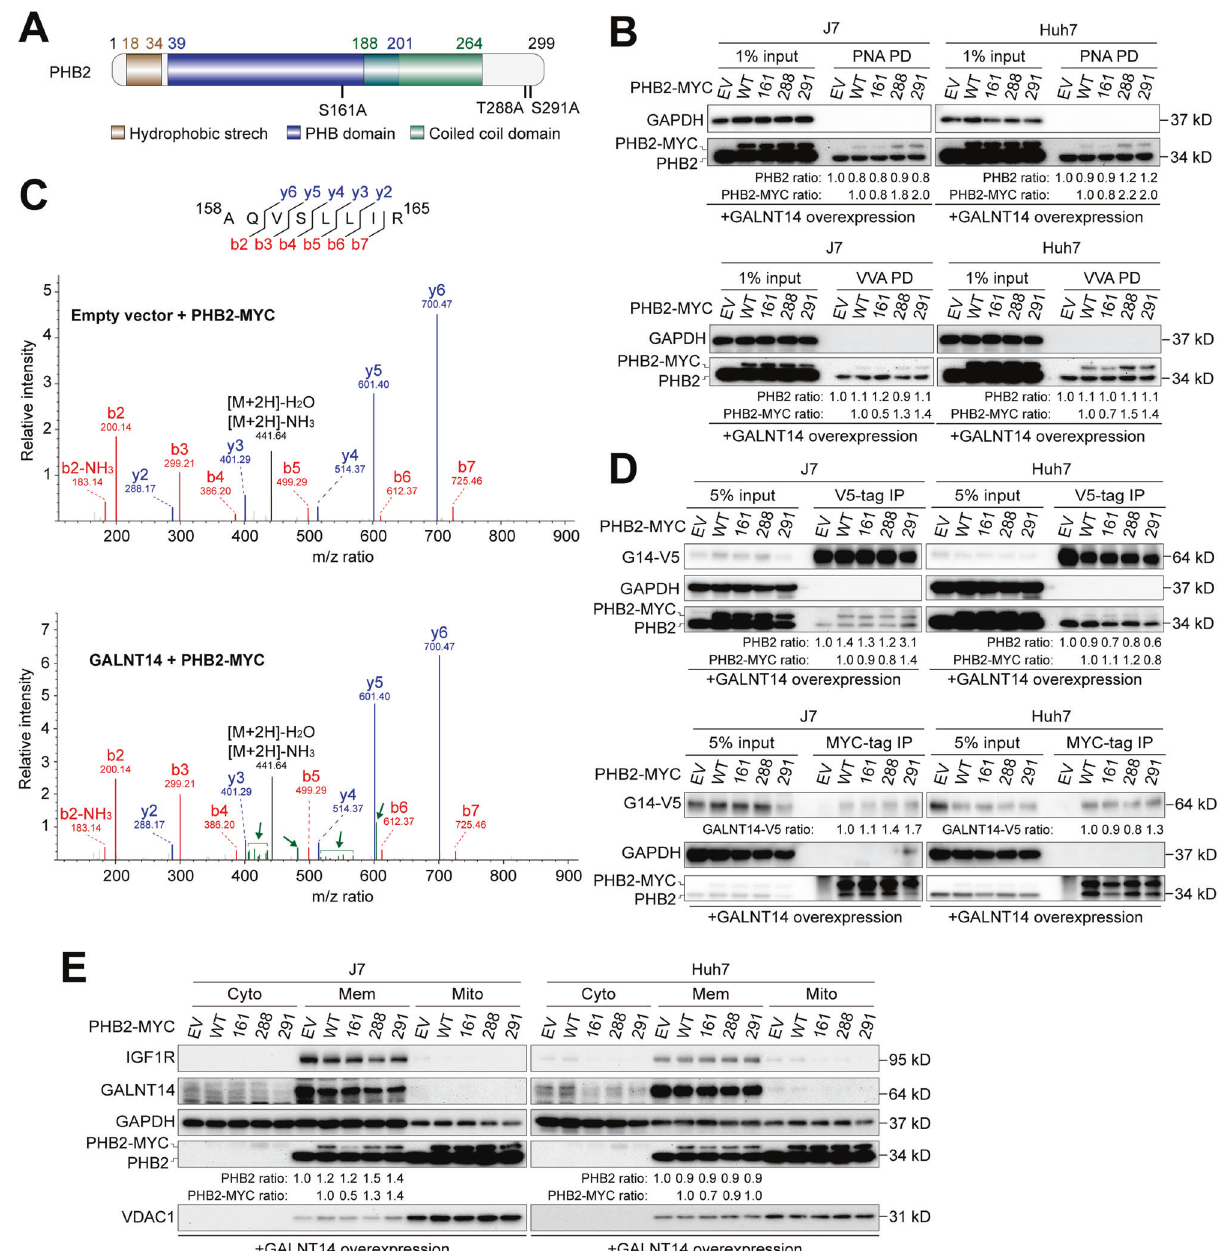
Fig. 4 Serine residue 161 of PHB2 serves as a target site for GALNT14-mediated O -glycosylation. A Schematic representation of predicted PHB2 domains and residues as O -glycosylation hotspots. B PNA- or VVA-mediated pulldown of PHB2 was performed using lysates of cells transfected with the indicated plasmids. C Spectrum of Serine-161-containing peptides derived from LC/MS/MS. Green bars and arrows indicate that there were certain uncharacterized modi fi cations on the fragmented peptides. m/z, the mass-to-charge ratio, where m is the molecular or atomic mass number and z is the charge number of the ion. D Western blot analysis following co-immunoprecipitation using samples of HCC cells transfected with the indicated plasmids. E Western blot analysis of subcellular fractions fractionated from cells transfected with the indicated plasmids, including cytosolic (Cyto), membranous (Mem) and mitochondrial (Mito). IGF1R was used as a speci fi c marker for the membrane fraction, while VDAC1 was used as a marker for the mitochondrial conducted. As shown in Fig. 7A, when IGFBP6-His immunopreci- pitation was performed, a comparable amount of endo-PHB2 was detected in all the pellets. However, a signi fi cantly reduced abundance of exo-PHB2 was detected in the samples expressing PHB2 has been demonstrated to co-localize and physically interact the Ser161Ala mutant. Consistently, when PHB2-MYC was with the IGF1R modulator IGFBP6 on the cell membrane [19]. To immunoprecipitated, IGFBP6 was detectable in the co- immunoprecipitants of the wild-type or Thr288Ala and Ser291Ala Ser161 plays a role in the association between PHB2 and IGFBP6, mutants, but not in the Ser161Ala mutant. IGFBP6 was almost a series of co-immunoprecipitation (co-IP) experiments were